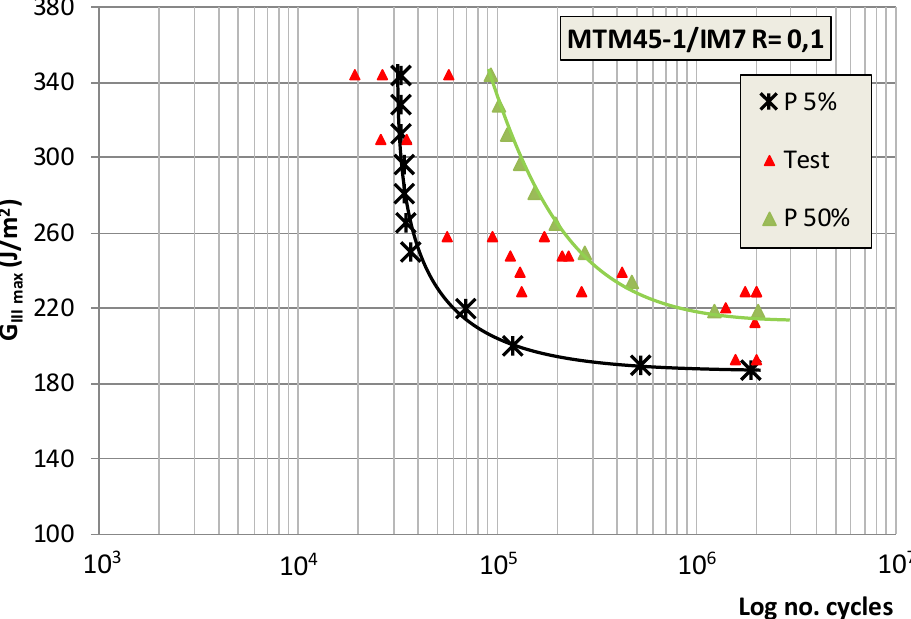
Figure 3. Fatigue behaviour of the material for fracture probabilities of 5% and 50%.